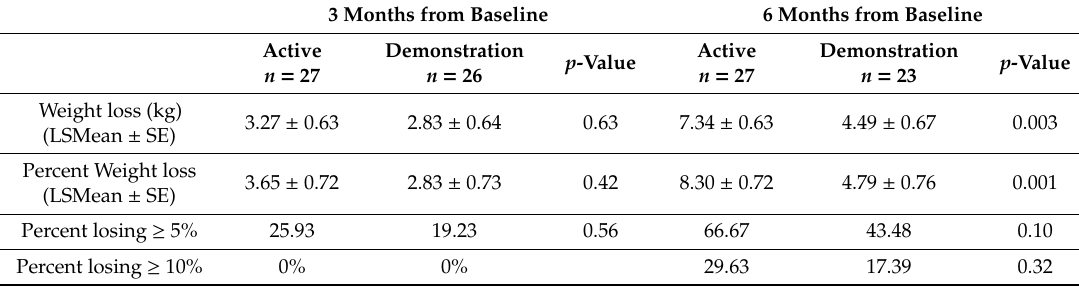
Table 2. Mean weight loss from baseline to three months and six months.